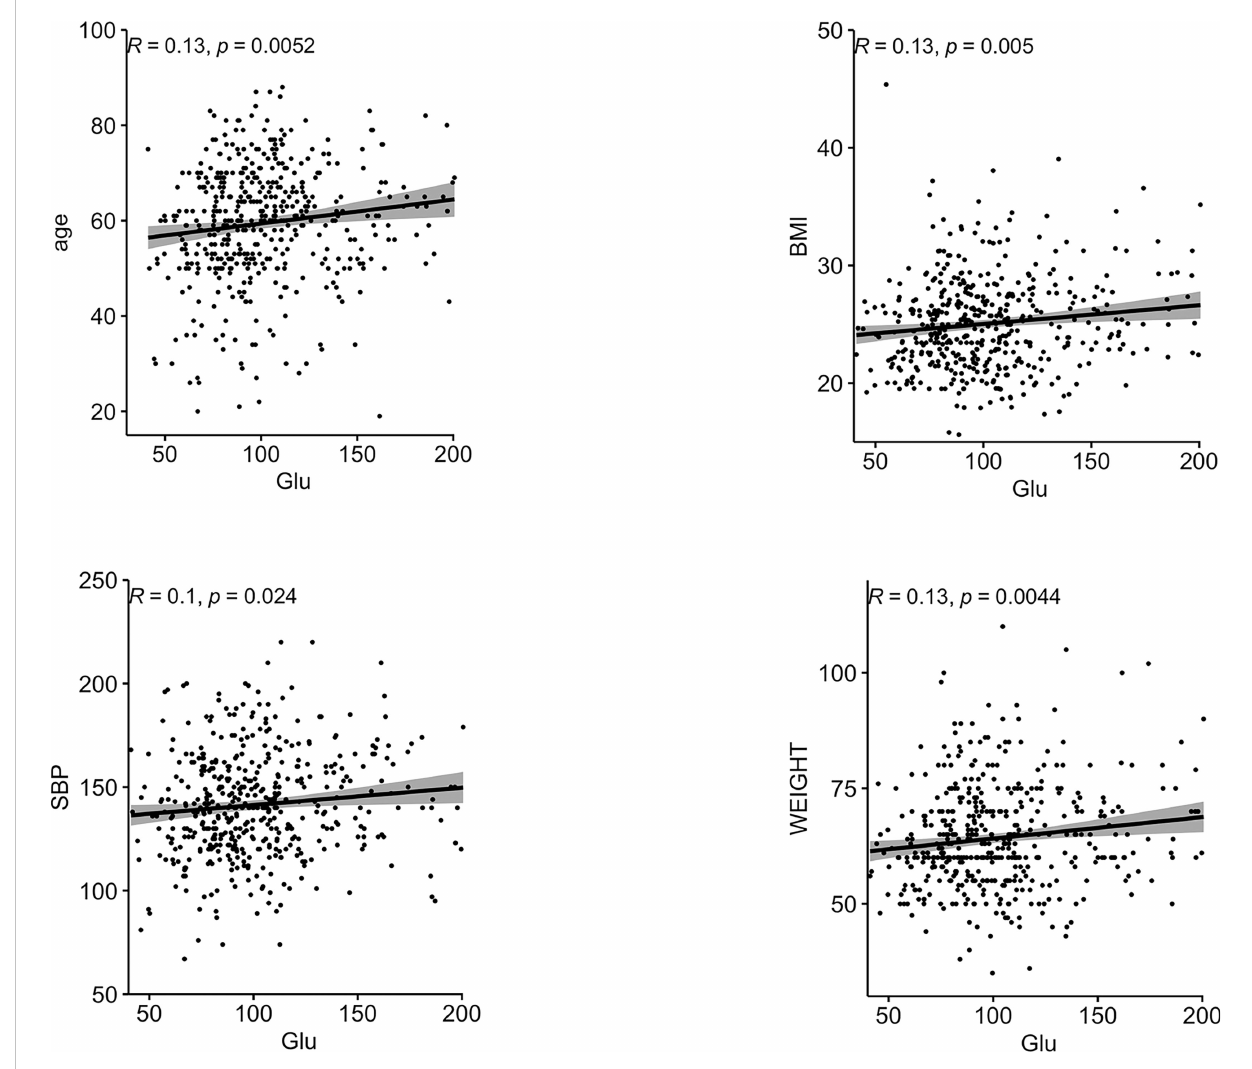
FIGURE 1 Correlation between Glu and each biochemical index in all people. BMI, body mass index; HbA1c, glycated hemoglobin; SBP, systolic blood pressure; Glu,